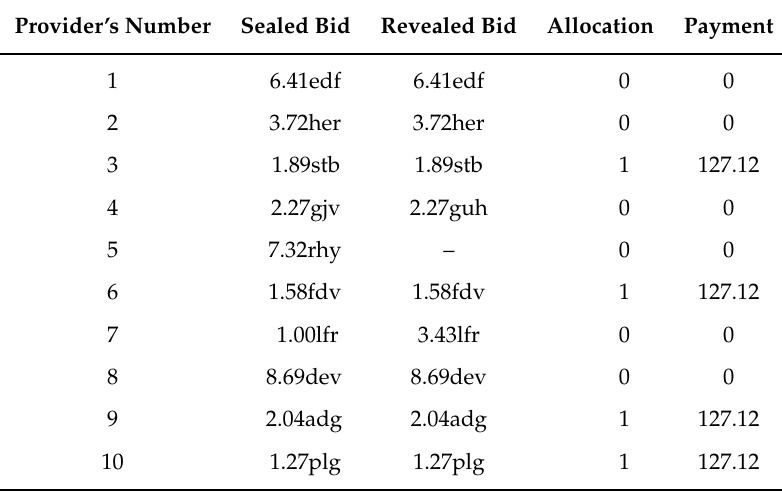
Figure 4. The total cost of demander in our mechanism. Table 2. Bidding information and allocation results of providers in transaction